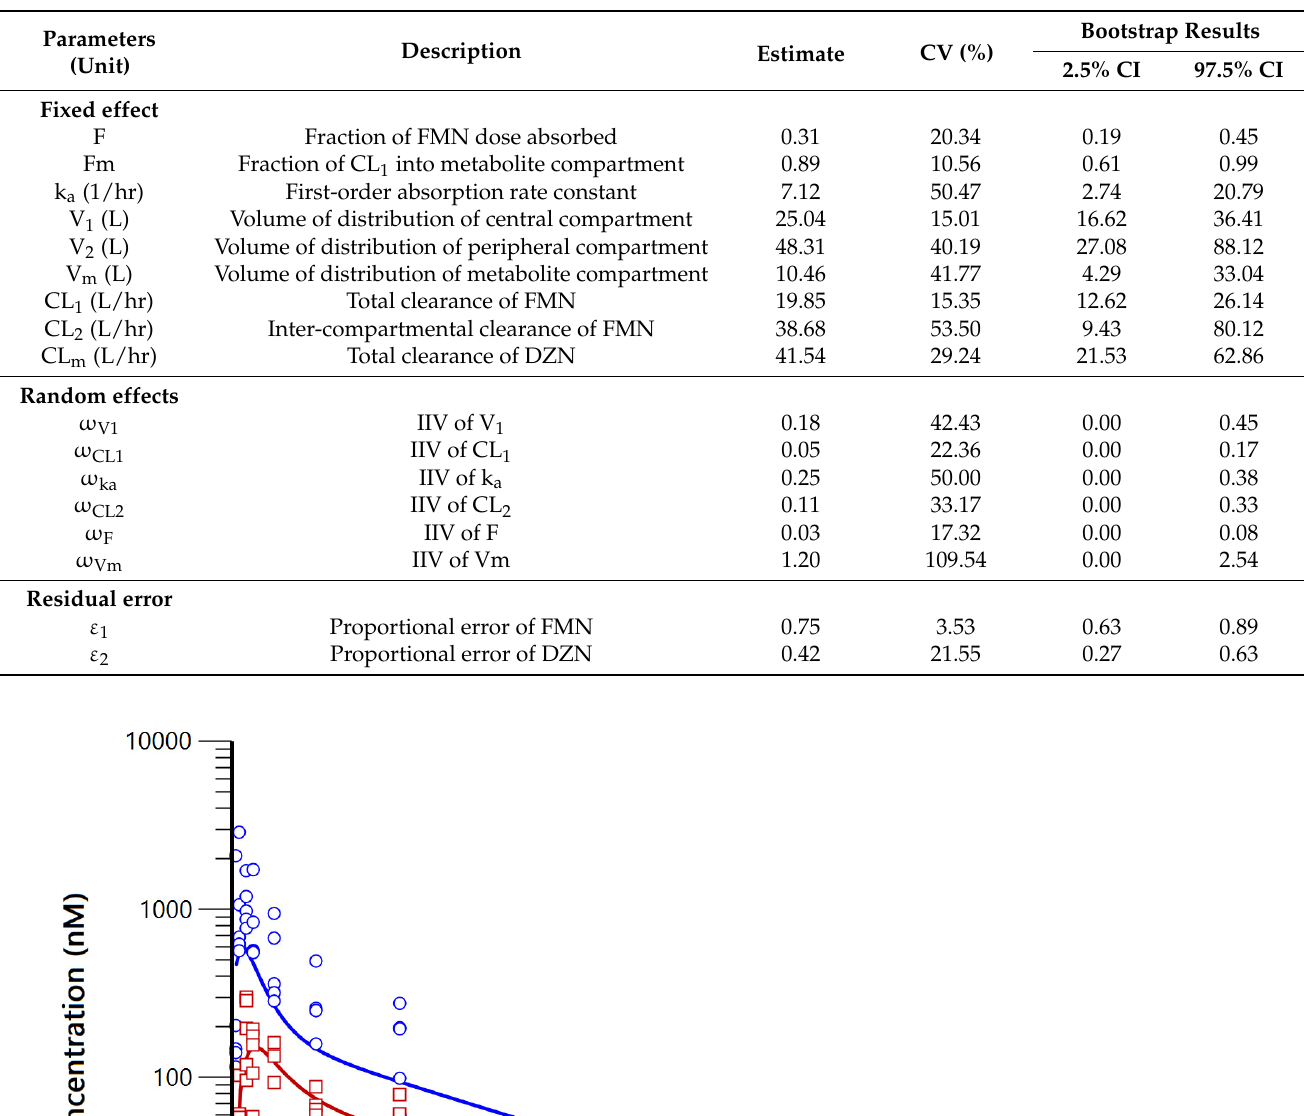
Table 6. The model estimated pharmacokinetic parameters for FMN and DZN.